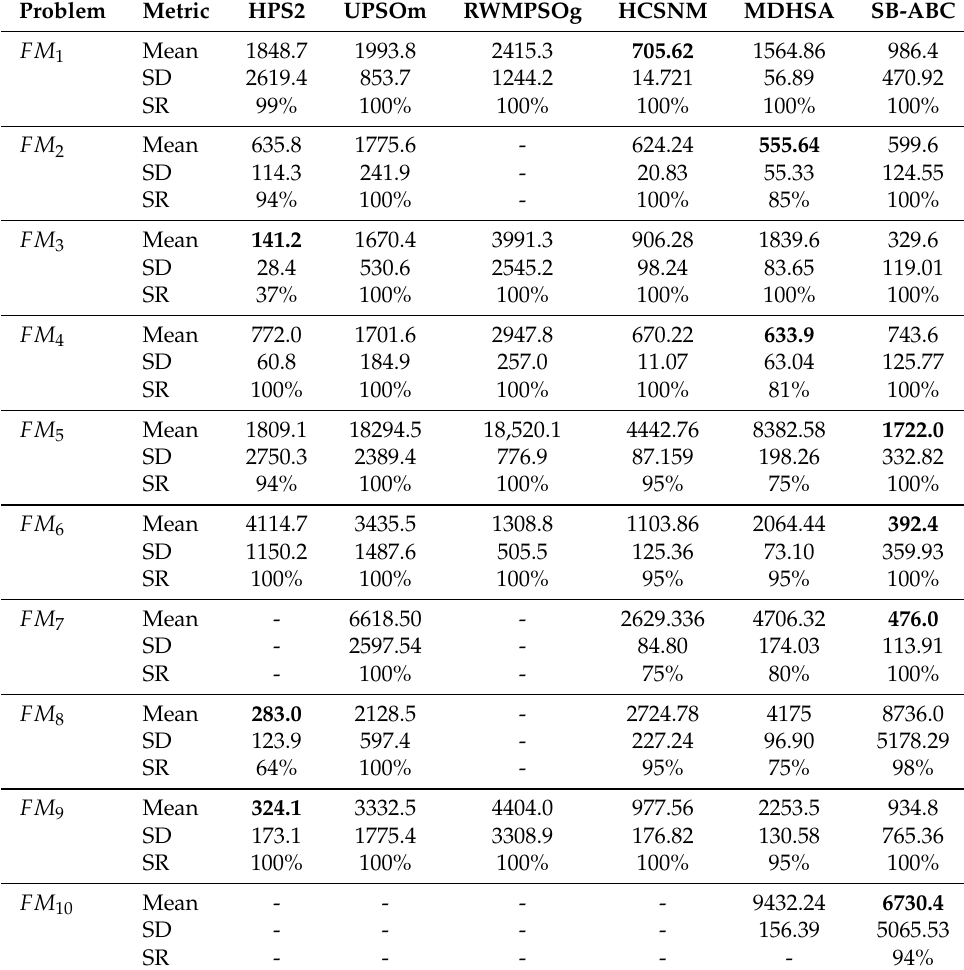
Table 6. Comparison results of the HPS2, UPSOm, RWMPSOg, HCSNM, MDHSA, HCSNM and SB-ABC for the FM 1 – FM 10 minimax